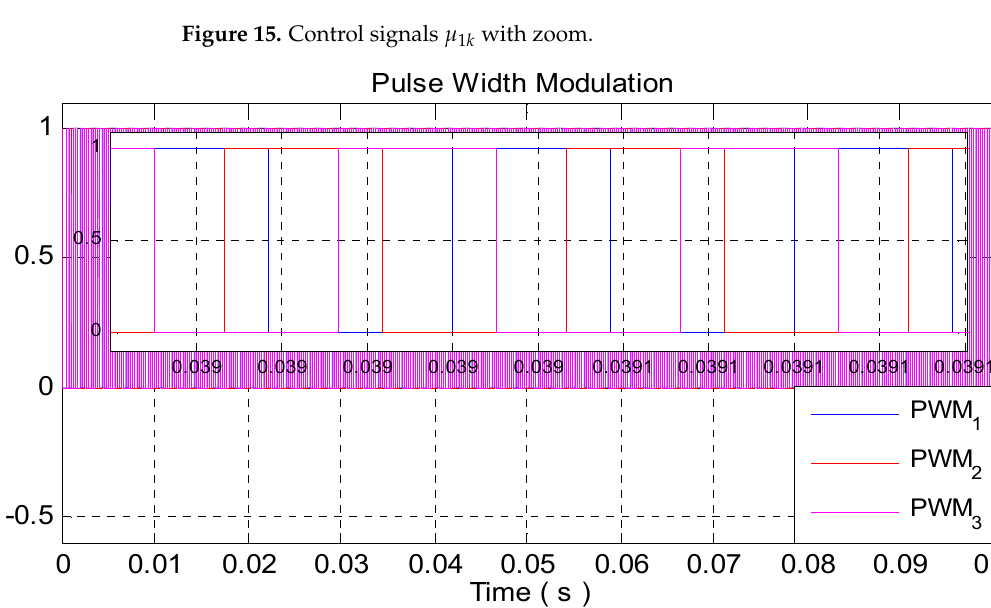
Figure 16. Pulse width modulation of IBBC with zoom.